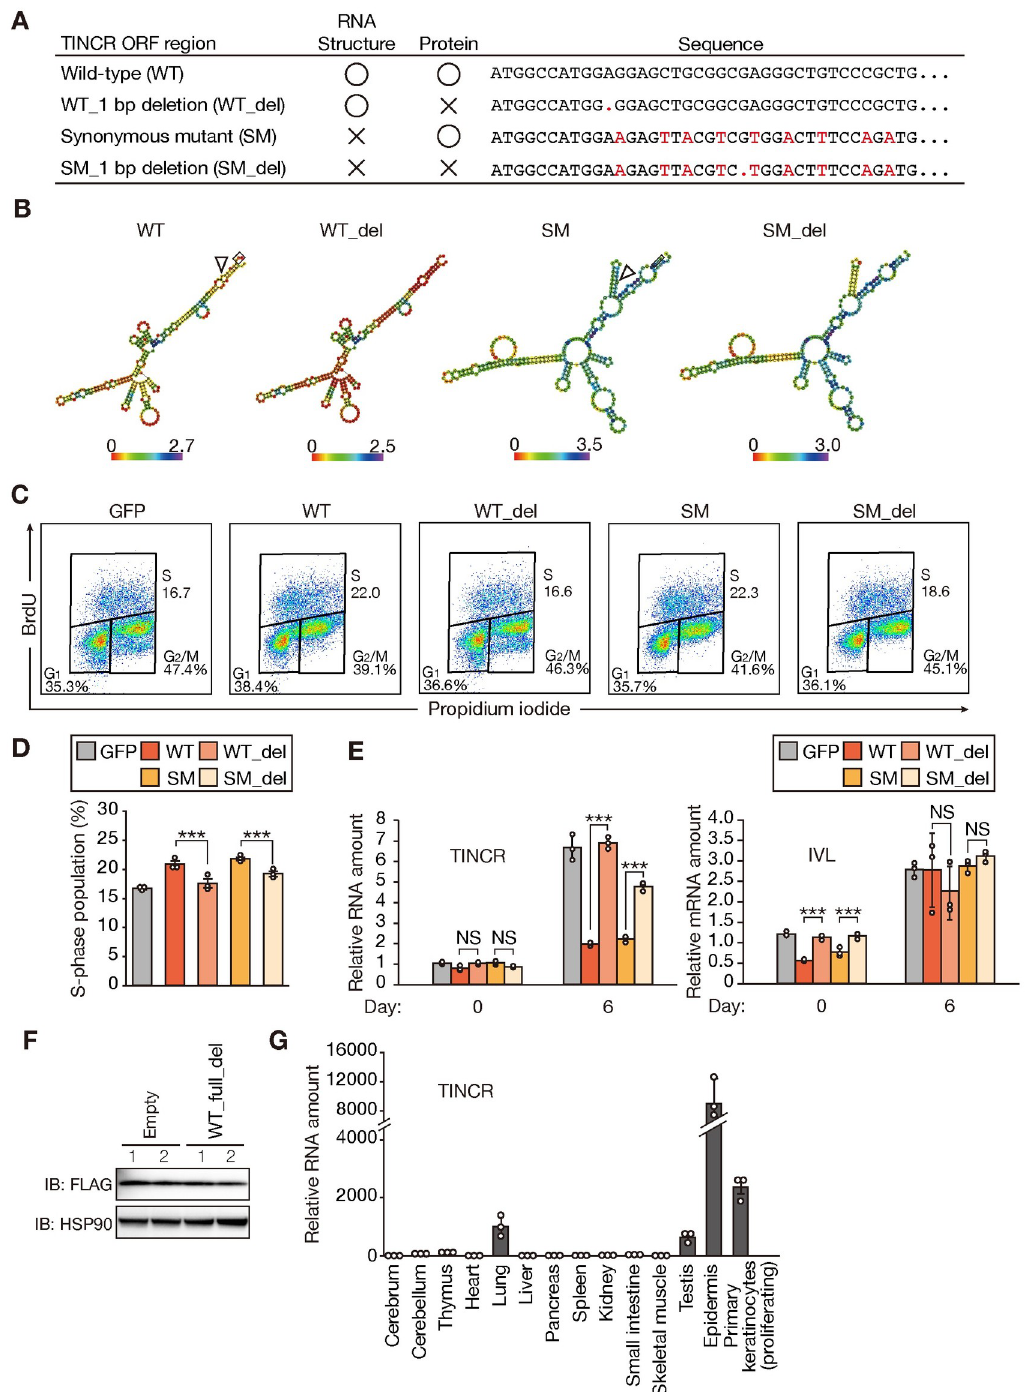
Fig 3. TUBL expression promotes proliferation of mouse primary keratinocytes in a manner independent of the secondary structure of TINCR RNA. (A) Summary of mutations introduced into the mouse TUBL ORF. (B) Predicted secondary structure and minimal free energy for WT, WT_del, SM, and SM_del. (C, D) Flow cytometric traces (C) and quantification (D) of BrdU incorporation for mouse primary keratinocytes stably expressing either GFP or WT, WT_del, SM, or SM_del forms of TINCR. Data in (D) are means ± SD (n = 3 independent experiments). ��� p < 0.005 (Student’s t test). (E) RT-qPCR analysis of TINCR and involucrin (IVL) mRNA abundance in mouse primary keratinocytes stably expressing either GFP or WT, WT_del, SM, or SM_del forms of TINCR and subjected to calcium-induced differentiation in vitro for 0 or 6 days. Data are means ± SD (n = 3